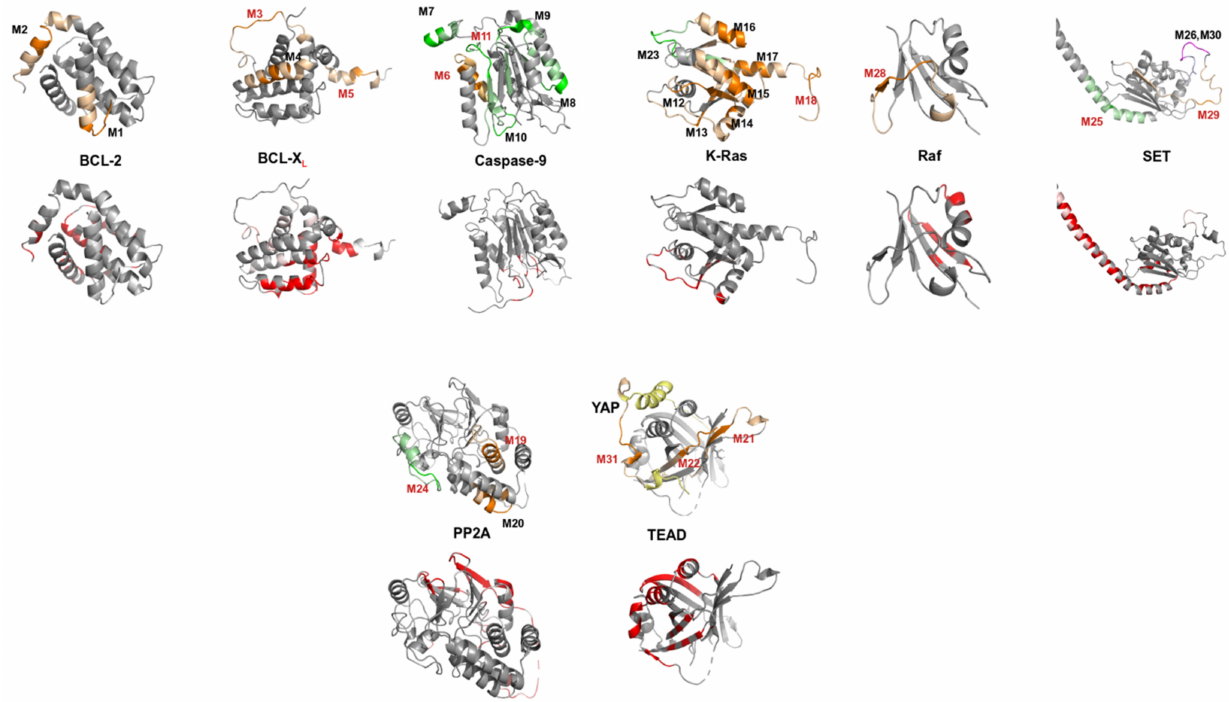
Figure 2. Top: For each of the 8 proteins having undergone a PEPscan, the location of the IPs in the structure is presented. For cases where the IPs of different PEPscans are presented, different colors are employed (green vs. orange). Darker shades correspond to the MOFs. MOFs are labeled as in Table 2. Red labels correspond to IPs showing some biological activity. Bottom: the residues most interacting in the complexes of structure available in the PDB are depicted using a red color